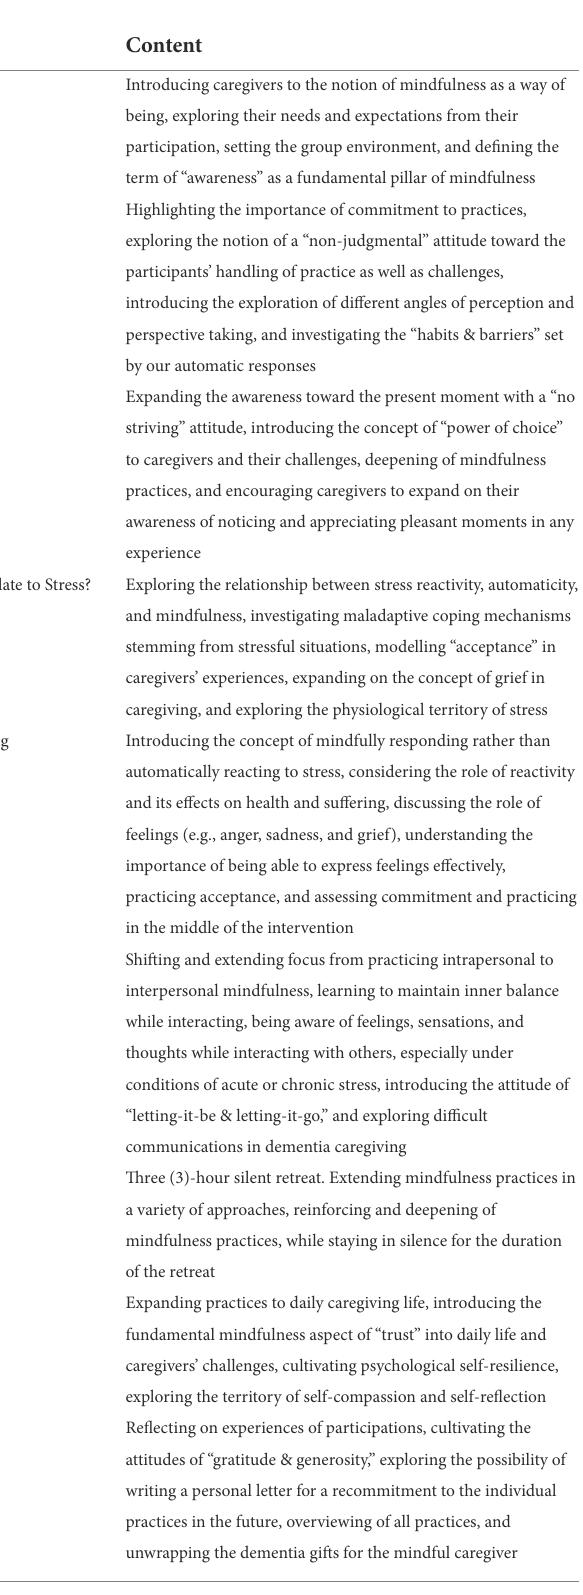
TABLE 2 Weekly MBSR adapted course